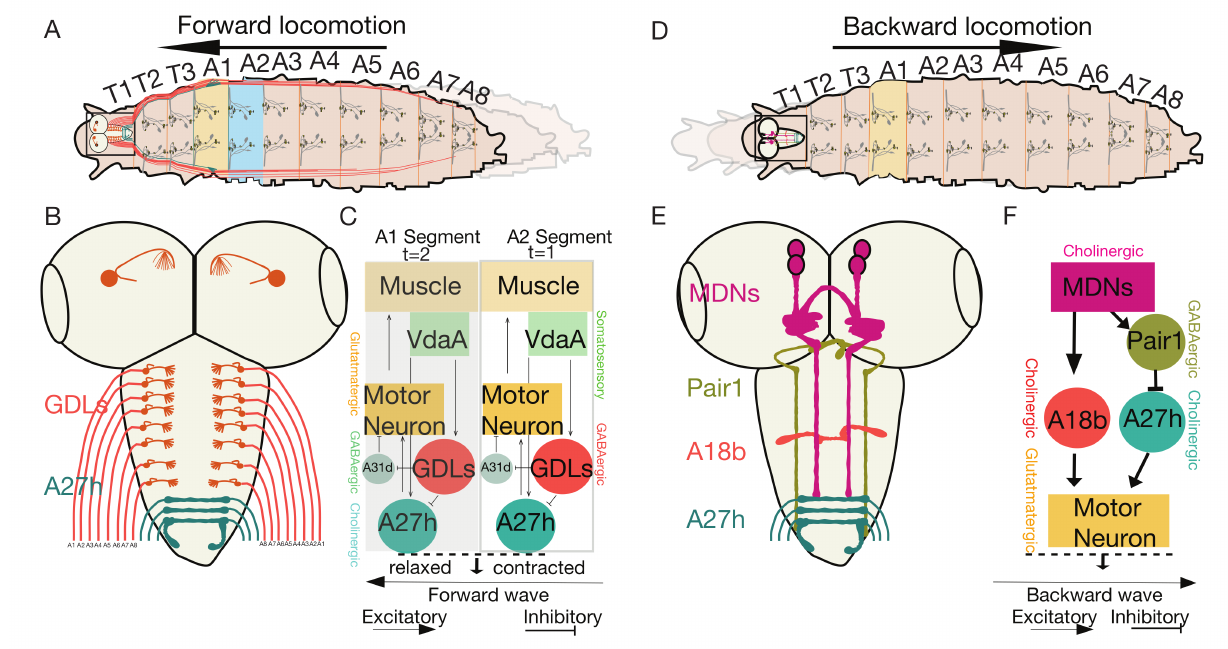
Figure 3. Neuronal pathways controlling forward and backward locomotion. ( A ) Schematic of Drosophila larvae (top view) depicting forward locomotion. ( B ) Schematic showing the anatomy of the larval CNS depicting expression of GDL interneurons (red) and A27h neurons (green) in VNC. ( C ) Neural circuit in a hemisegment of muscles leading to the generation of forward locomotion (adapted and modified from [25]). ( D ) Schematic of Drosophila larvae (top view) depicting backward locomotion. ( E ) Schematic showing anatomy of larval CNS depicting expression of descending MDN, inhibitory Pair1, interneurons A18b, and premotor A27h neurons in brain and VNC of Drosophila larvae [23]. ( F ) A neural circuit in a hemisegment of muscle eliciting backward locomotion (adapted and modified from